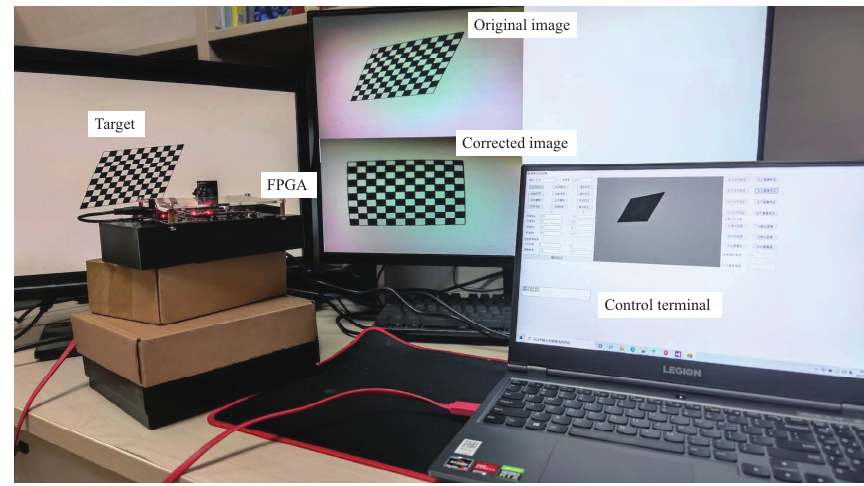
Figure 15. Test environment for the proposed